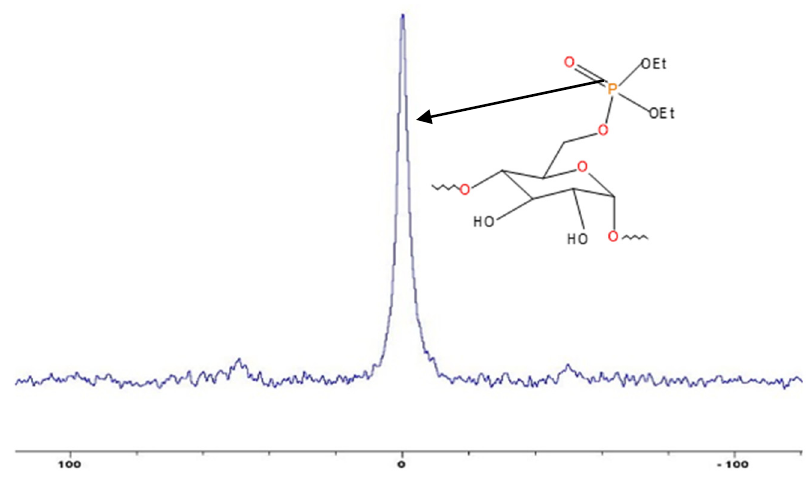
Figure 2. 31 P-NMR spectrum of potato starch modified with phosphate groups (the abscissa denotes the chemical shift values, δ , in ppm, and the ordinate corresponds to the signal intensity in arbitrary units).